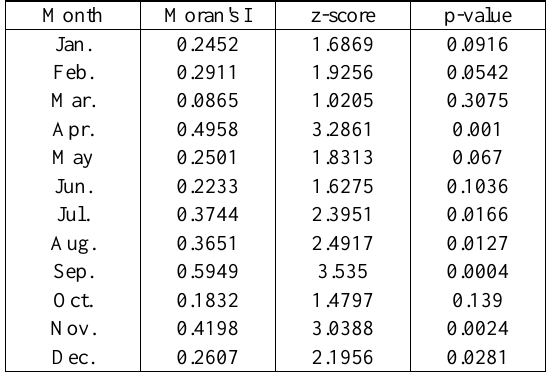
Table 2. Jiangsu Province ‘ s monthly mean Moran's I of AOD from 2007 to 2016